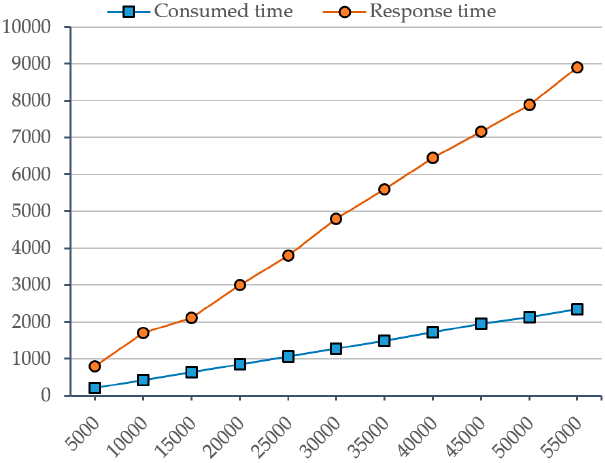
Figure 12. The consumed time changes with the number of generated instances (blue square markers) and the response time changes with the number of individual knowledge to query (yellow circle markers).